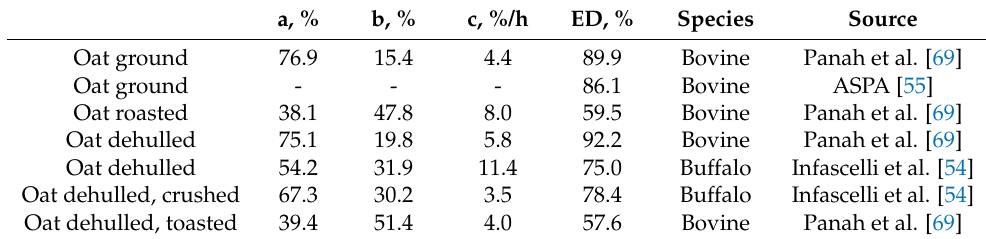
Table 4. Protein degradability of raw and treated oat grains.